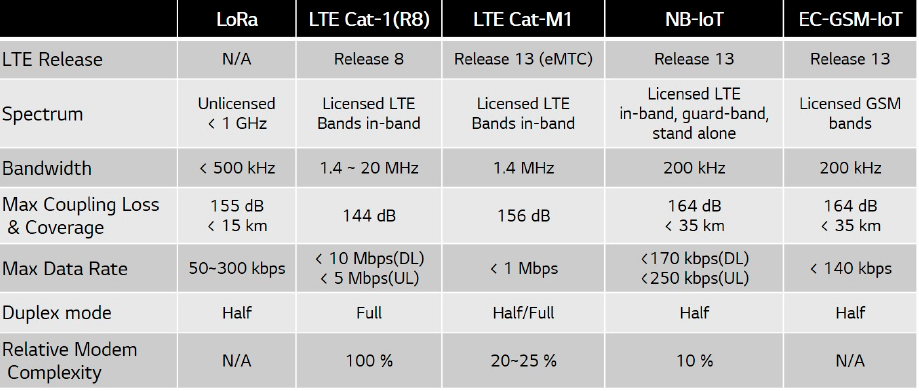
Figure 2. Comparison between narrowband (NB)-IoT and other technologies.